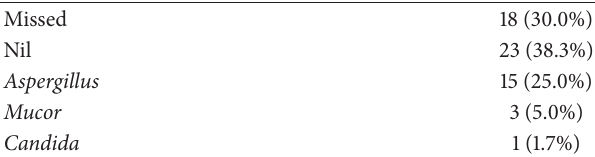
Table 7: Fungal growth in